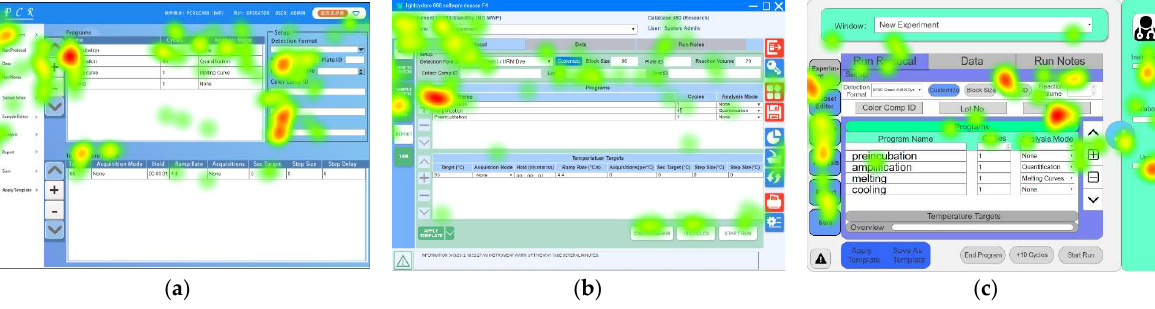
Figure 10. Hot maps of eye fixation points on Scheme ( A – C ). ( a ) Scheme A;( b ) Scheme B; ( c ) Scheme C ．